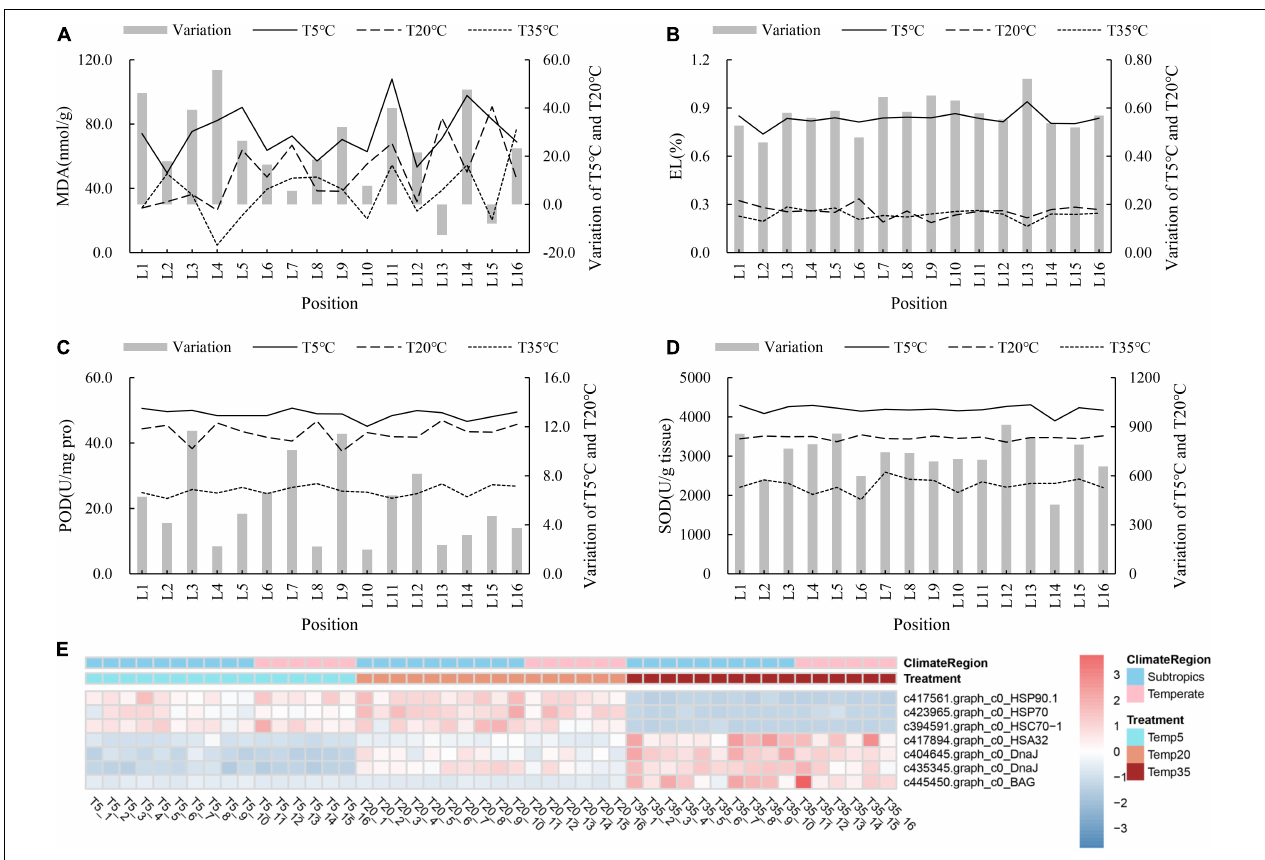
FIGURE 6 | Analysis of stress response to the different temperature in bermudagrass. Malondialdehyde (MDA) content (A) , EL (B) , POD activity (C) , and SOD (D) of all bermudagrass materials with T5, T20, and T35 treatment, respectively. The left of histogram showing variation between T5 and T20 treatment. (E) Heatmap showing the expression profile of DEGs involved in abiotic stress